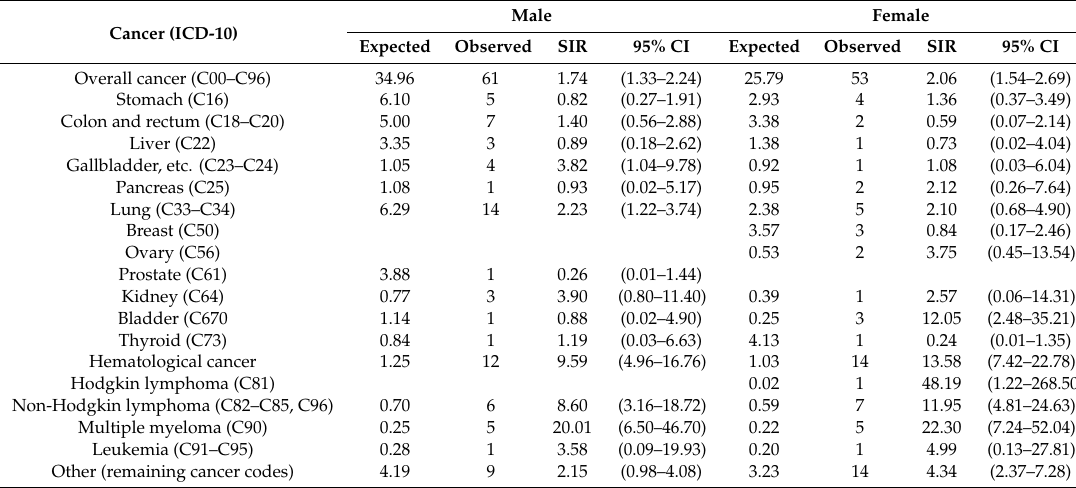
Table 3. Estimation of cancer risk according to sex in